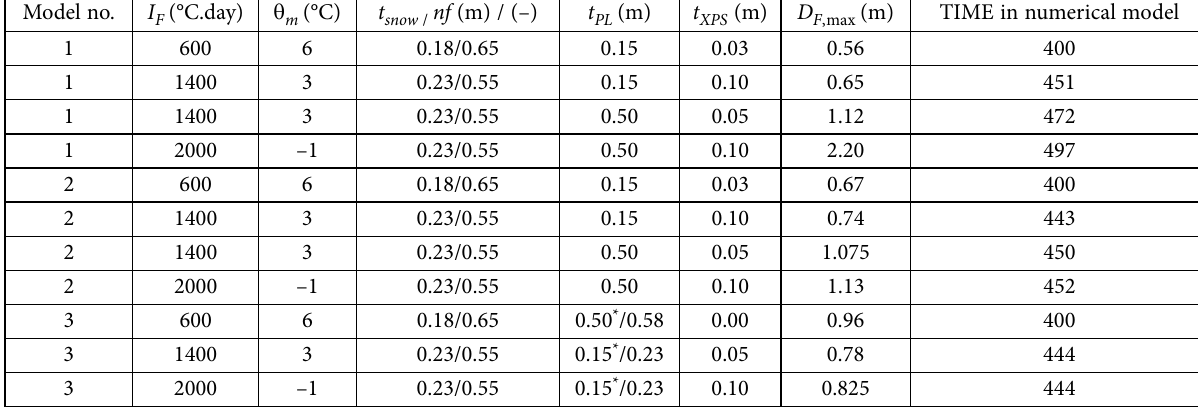
Note: * in the axis of the double-track